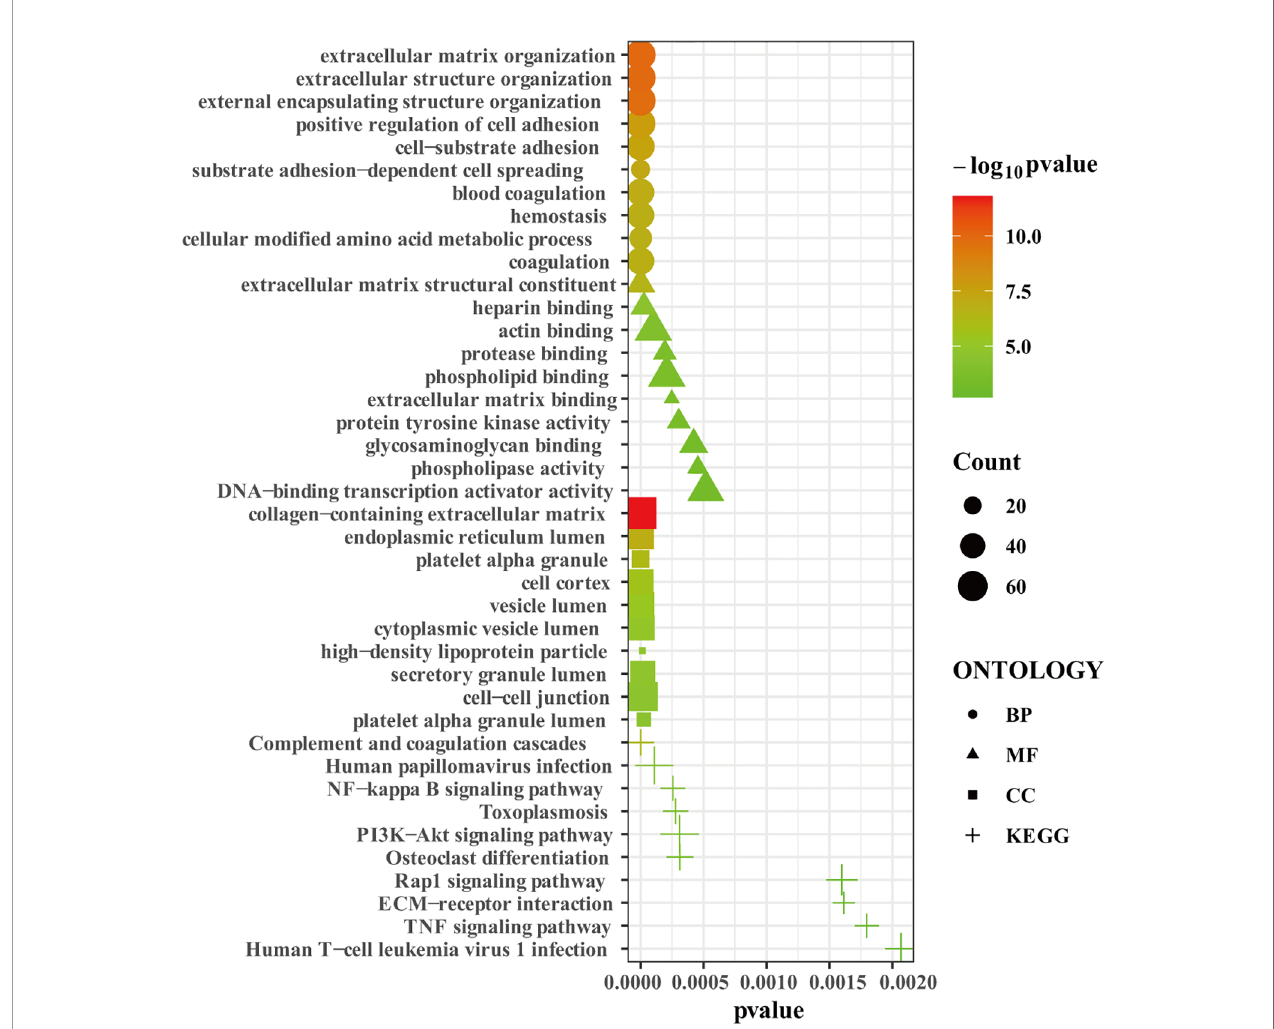
FIGURE 3 | The GO and KEGG enrichment analysis. Bubble plot showing the top 10 enriched terms in biological process, molecular function, cell component, and KEGG pathways,